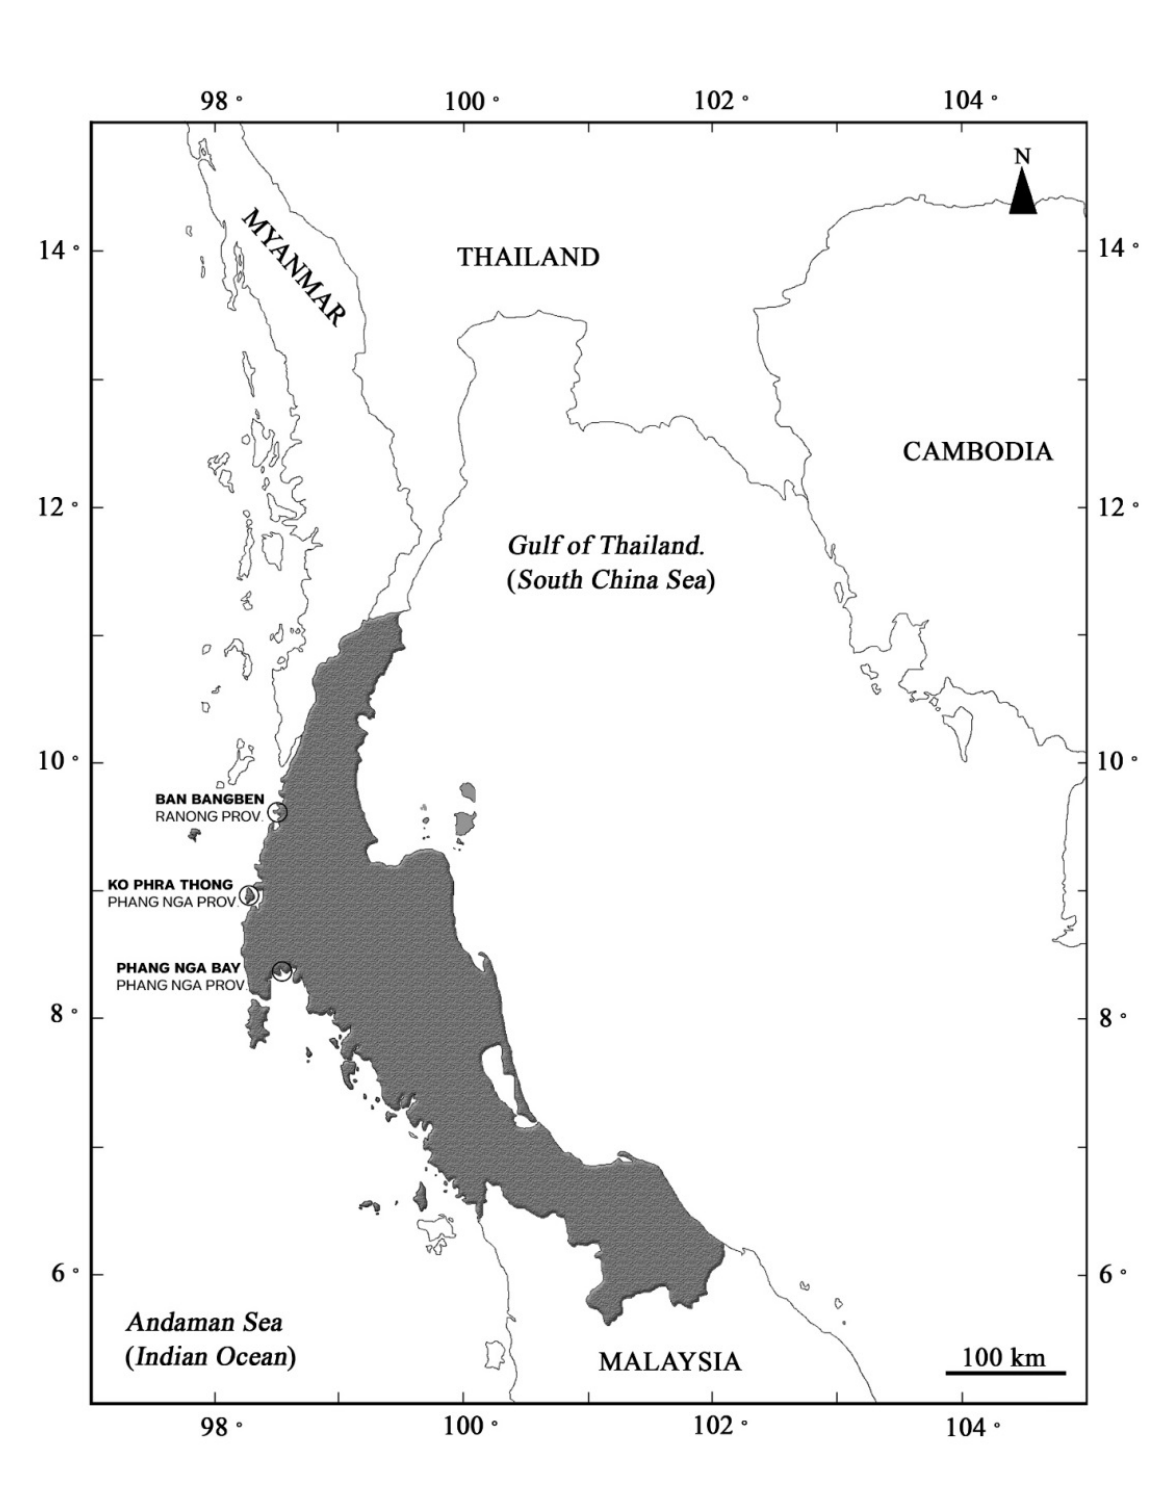
Fig. 1. Map of peninsular Thailand which is bordered by the Gulf of Thailand, a part of the South China Sea in the East and the Andaman Sea (Indian Ocean) in the West. The provenance of the three new species is